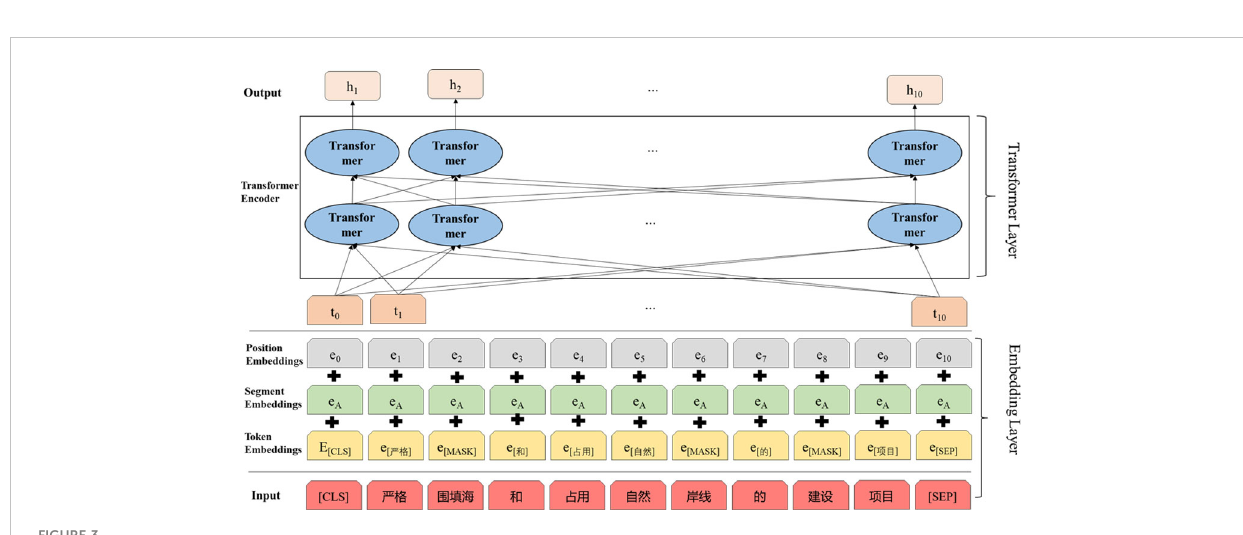
FIGURE 3 The Chinese BERT-WWM model